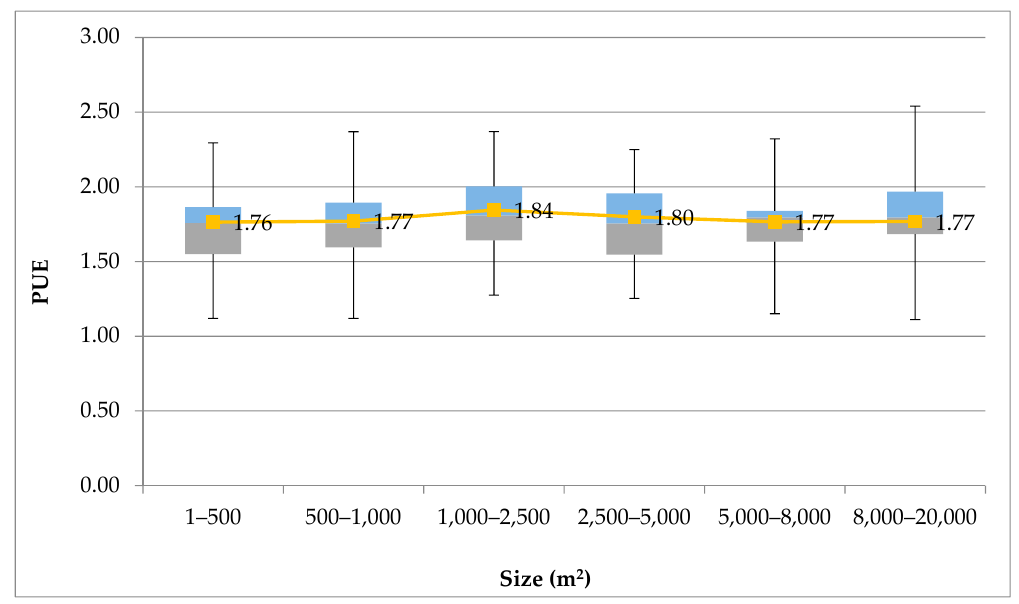
Figure 4. Average PUE for different size classifications.